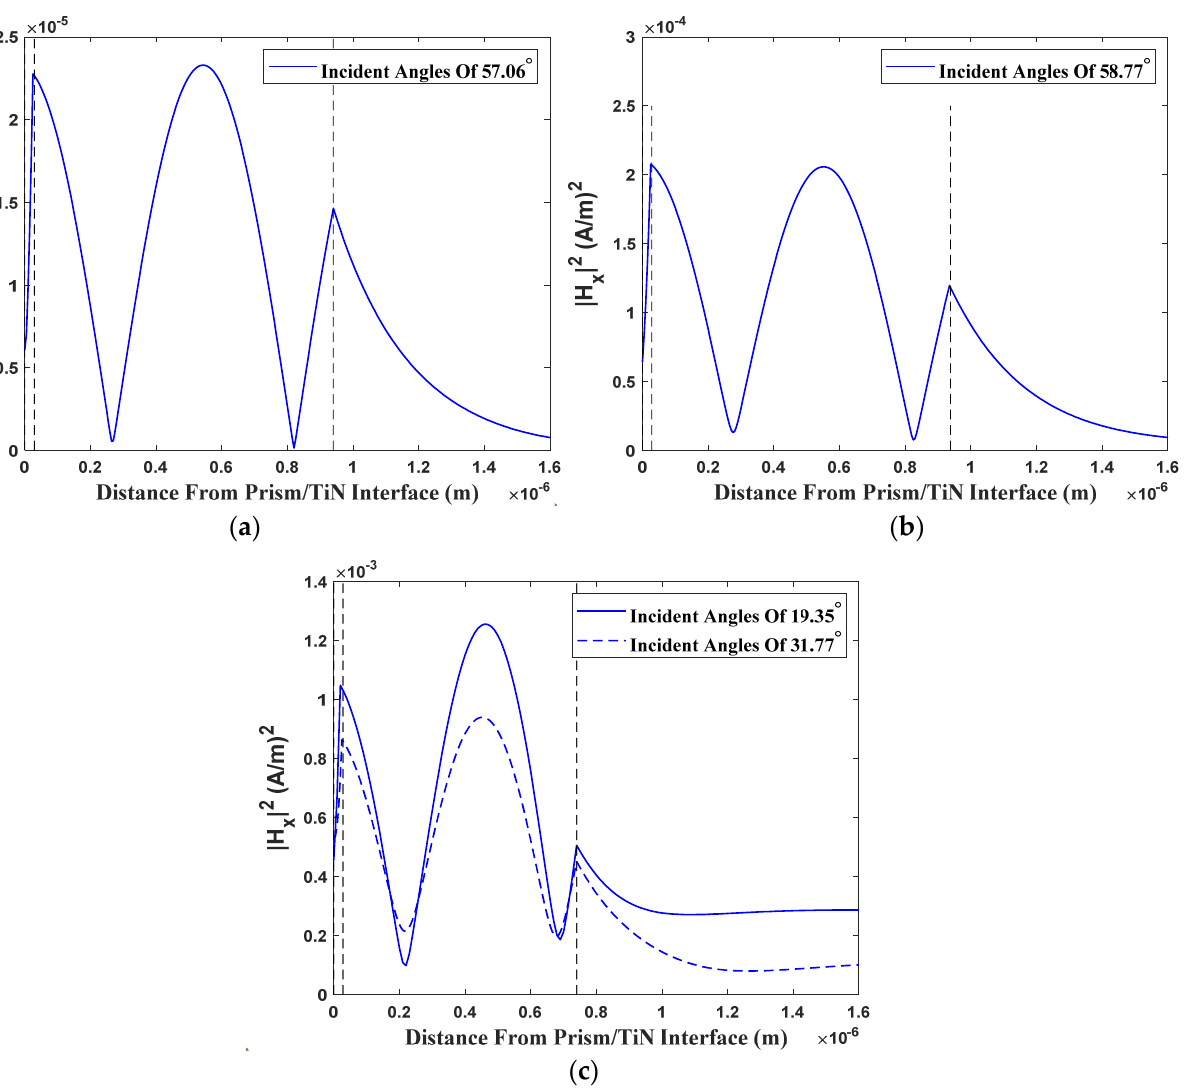
Figure 5. The magnetic field distribution for TE–polarized light for: ( a ) the sapphire prism/29.42 nm TiN/909.83 nm AlN/air sensor for an incident angle of 57.06 ° , ( b ) the magnesium oxide prism/28.33 nm TiN/ 909.50 nm AlN/air sensor for an incident angle of 58.77°, and ( c ) the silicon/28.33 nm TiN/ 711.88 nm AlN/air sensor for incident angles of 19.35° (solid line) and 31.77° (dash line).